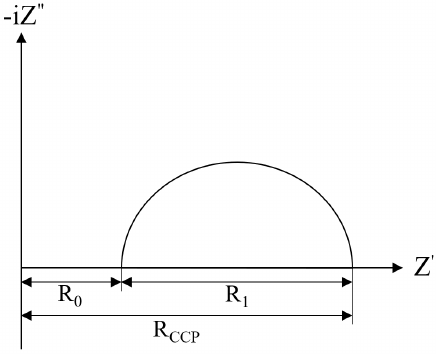
Figure 12. Typical Nyquist plot for concrete.